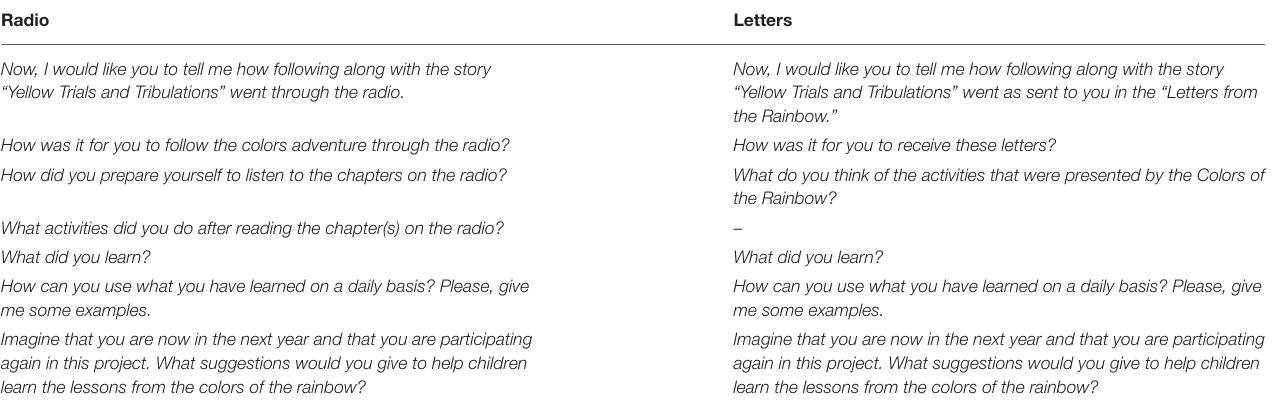
TABLE 1 | Semi-structured interview script. Radio